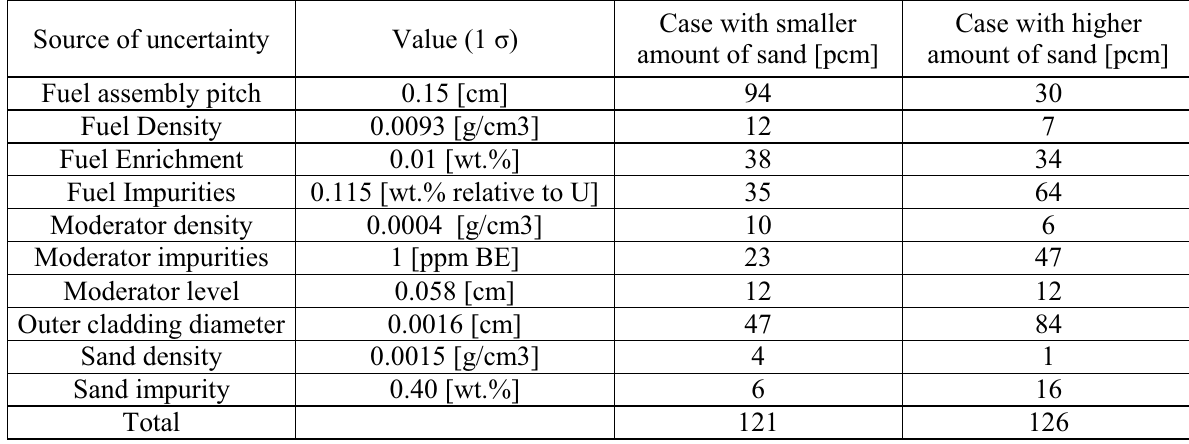
Table I. Sources of uncertainties in